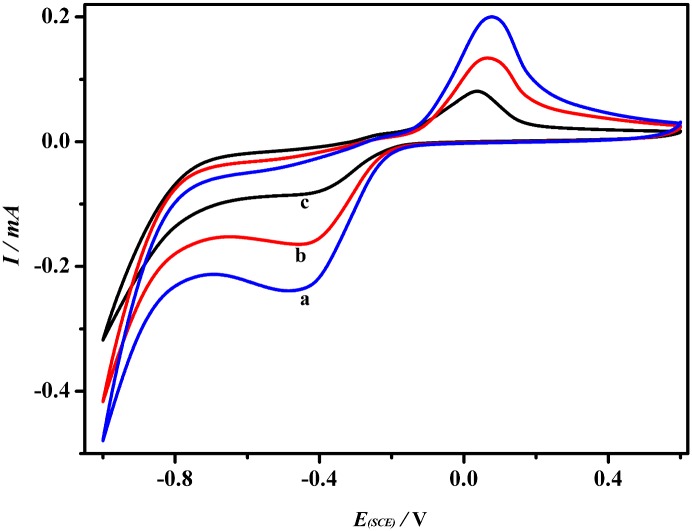
CV of CuS-GeO2-TiO2 composite coating electrode (a) Ultraviolet light, (b) Visible light, and (c) Dark.